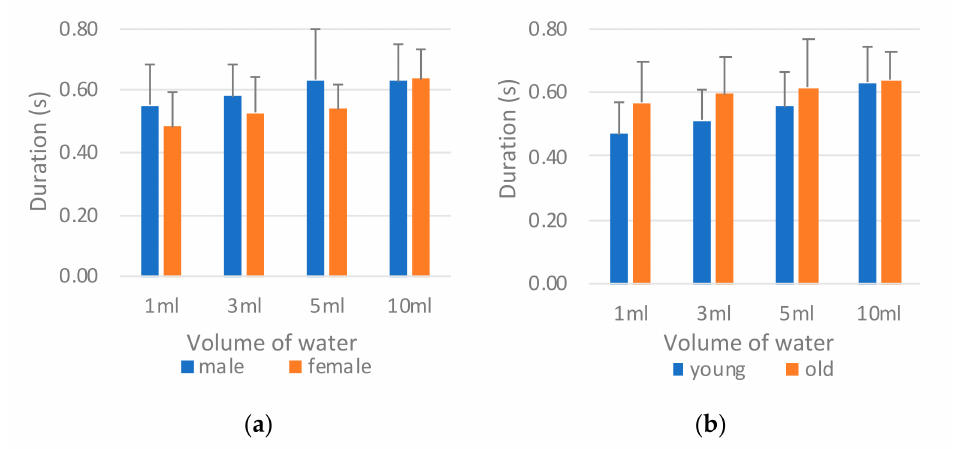
Figure 13. Comparison of the second phase duration ( T TC2 ) in the thyroid cartilage excursion by ( a ) sex and ( b ) age. Table 9. Analysis of variance results of second phase duration ( T TC1 ) in the thyroid cartilage